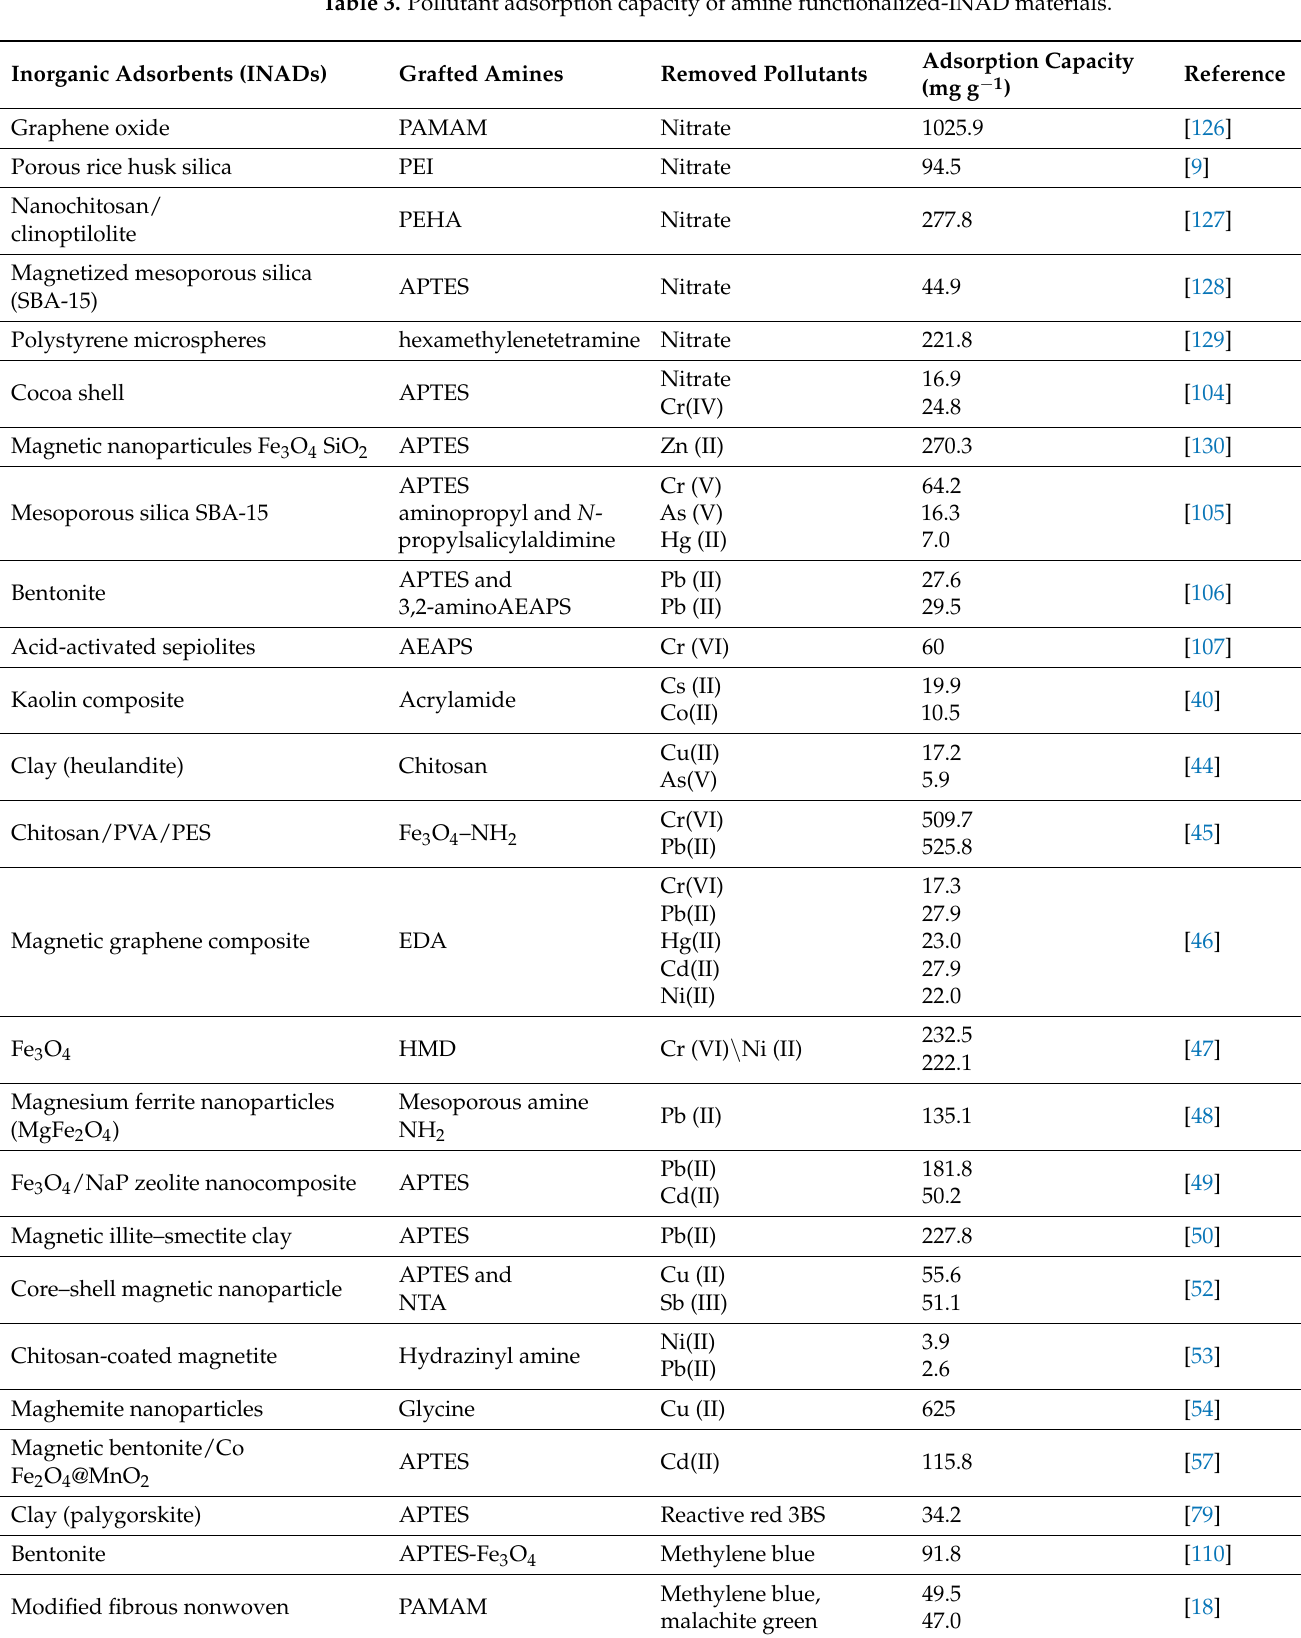
Table 3. Pollutant adsorption capacity of amine functionalized-INAD